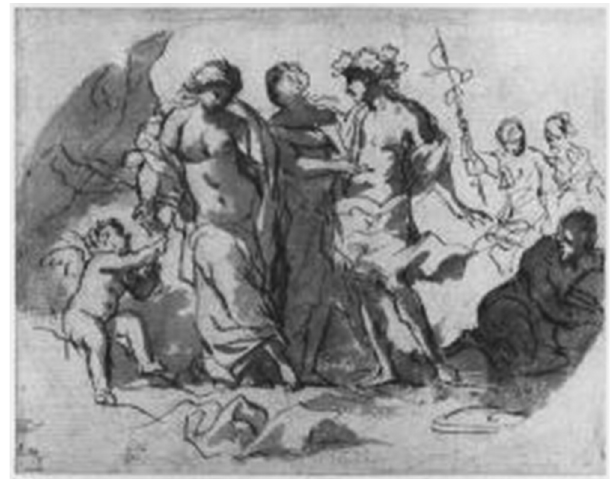
Figure 22: Giovanni Francesco Romanelli, Bacchus and Ariadne , 17th C. British Museum, London. Public